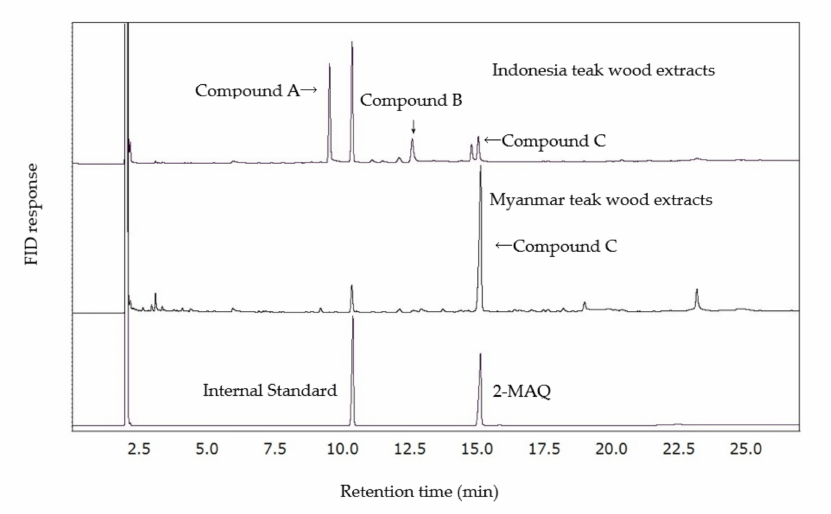
Figure 1. Gas chromatogram of Indonesia and Myanmar teak wood